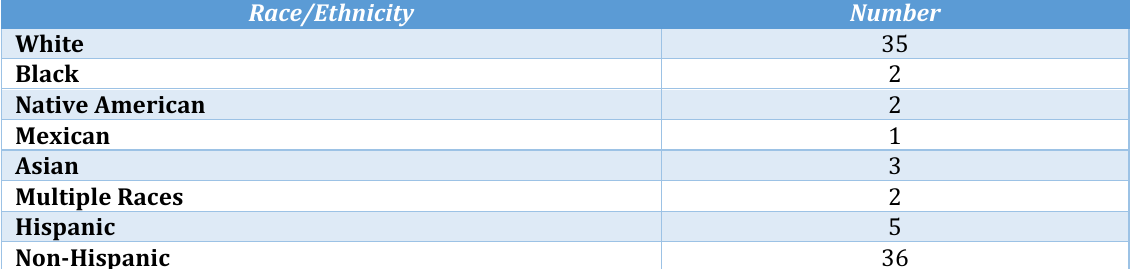
Table 2: Race and Ethnicity